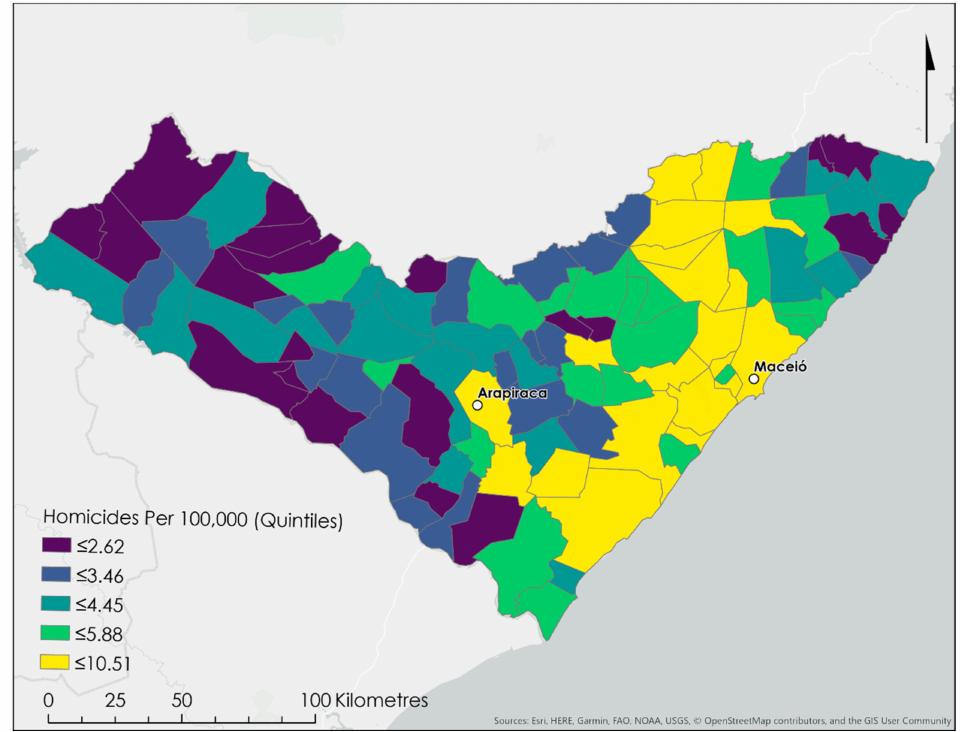
Figure 1. Spatial distribution of crude homicide rates in the Brazilian Federal State of Alagoas, featuring clustering of high rates in the two largest cities of Macie ó and Arapiraca, along the relatively wealthy Atlantic coastal region, and in the sugarcane corridor north of Macie ó